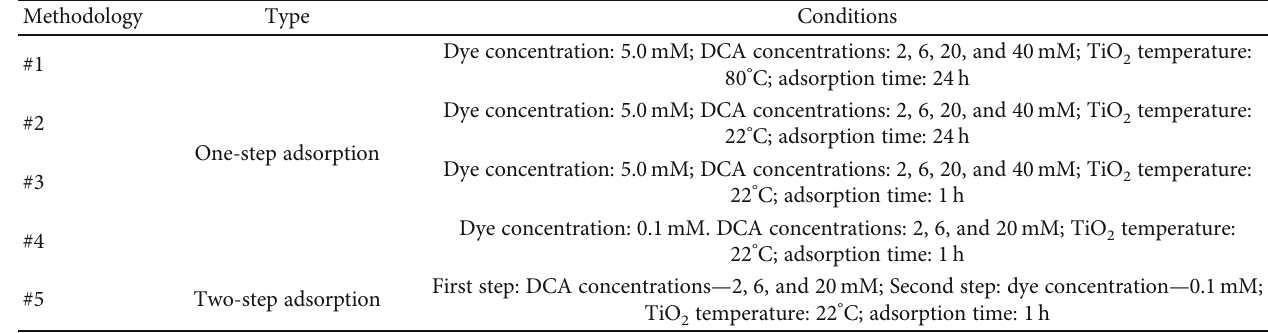
Table 1: Experimental conditions for the study of coadsorption of deoxycholic acid (DCA) and cyanine 13 as a model in methanol solutions on TiO mesoporous 2